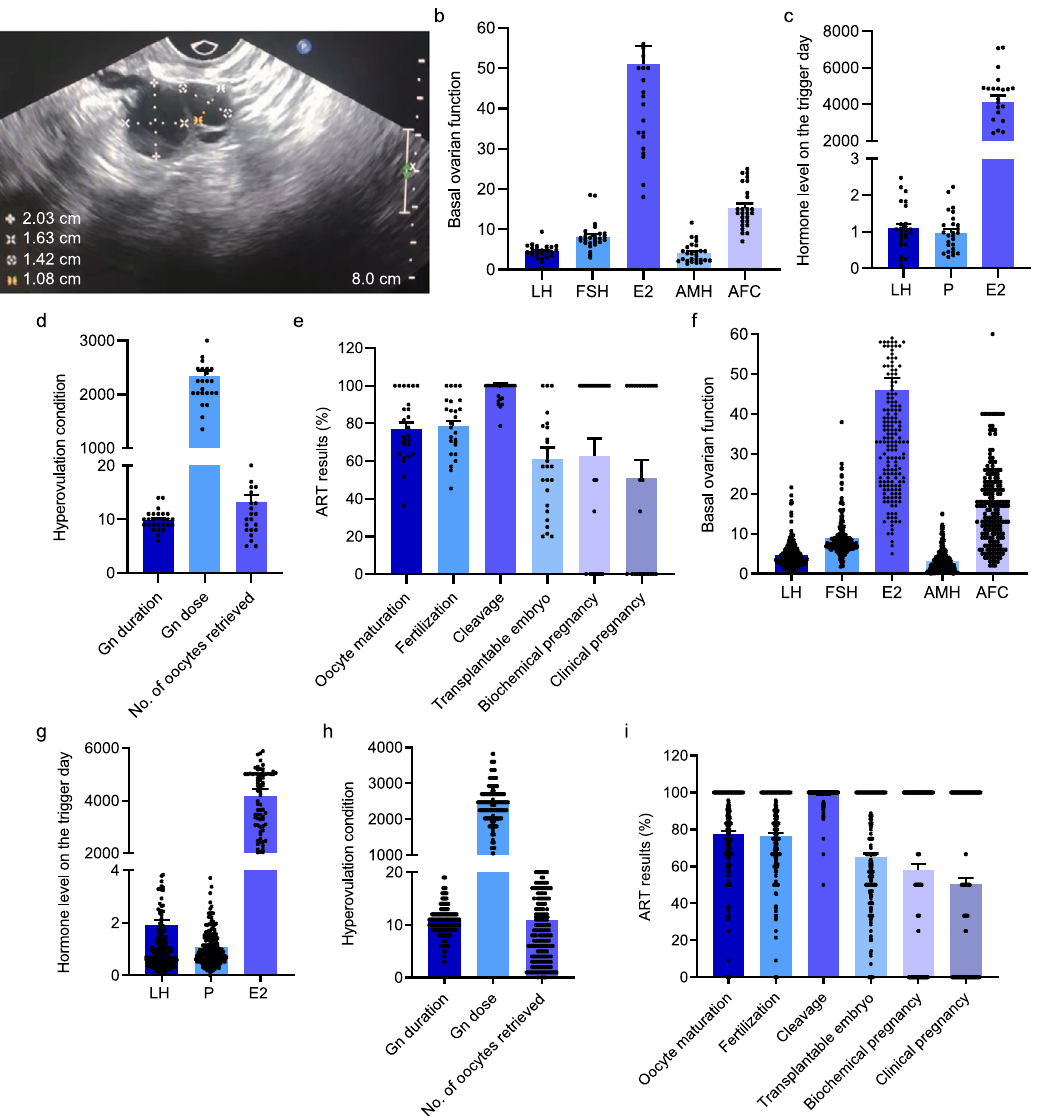
Fig. 1 The relevant clinical epidemiological information of 26 participants in this study. a Representative ultrasonic image of large follicles and matched- small follicles. b The basal ovarian function included LH (mIU/ml), FSH (mIU/ml), E2 (pg/ml), AMH (ng/ml) and AFC. c The levels of LH, P (nmol/L), E2 on the trigger day are presented. d Ovarian stimulation parameters (Gn dose and Gn duration) and number of oocytes retrieved could re fl ect the condition of hyperovulation. e ART results included embryonic development and pregnancy results. f – i Additional 200 participants ’ relevant clinical epidemiological information included the basal ovarian function, hormone level on the trigger day, hyperovulation condition, and ART